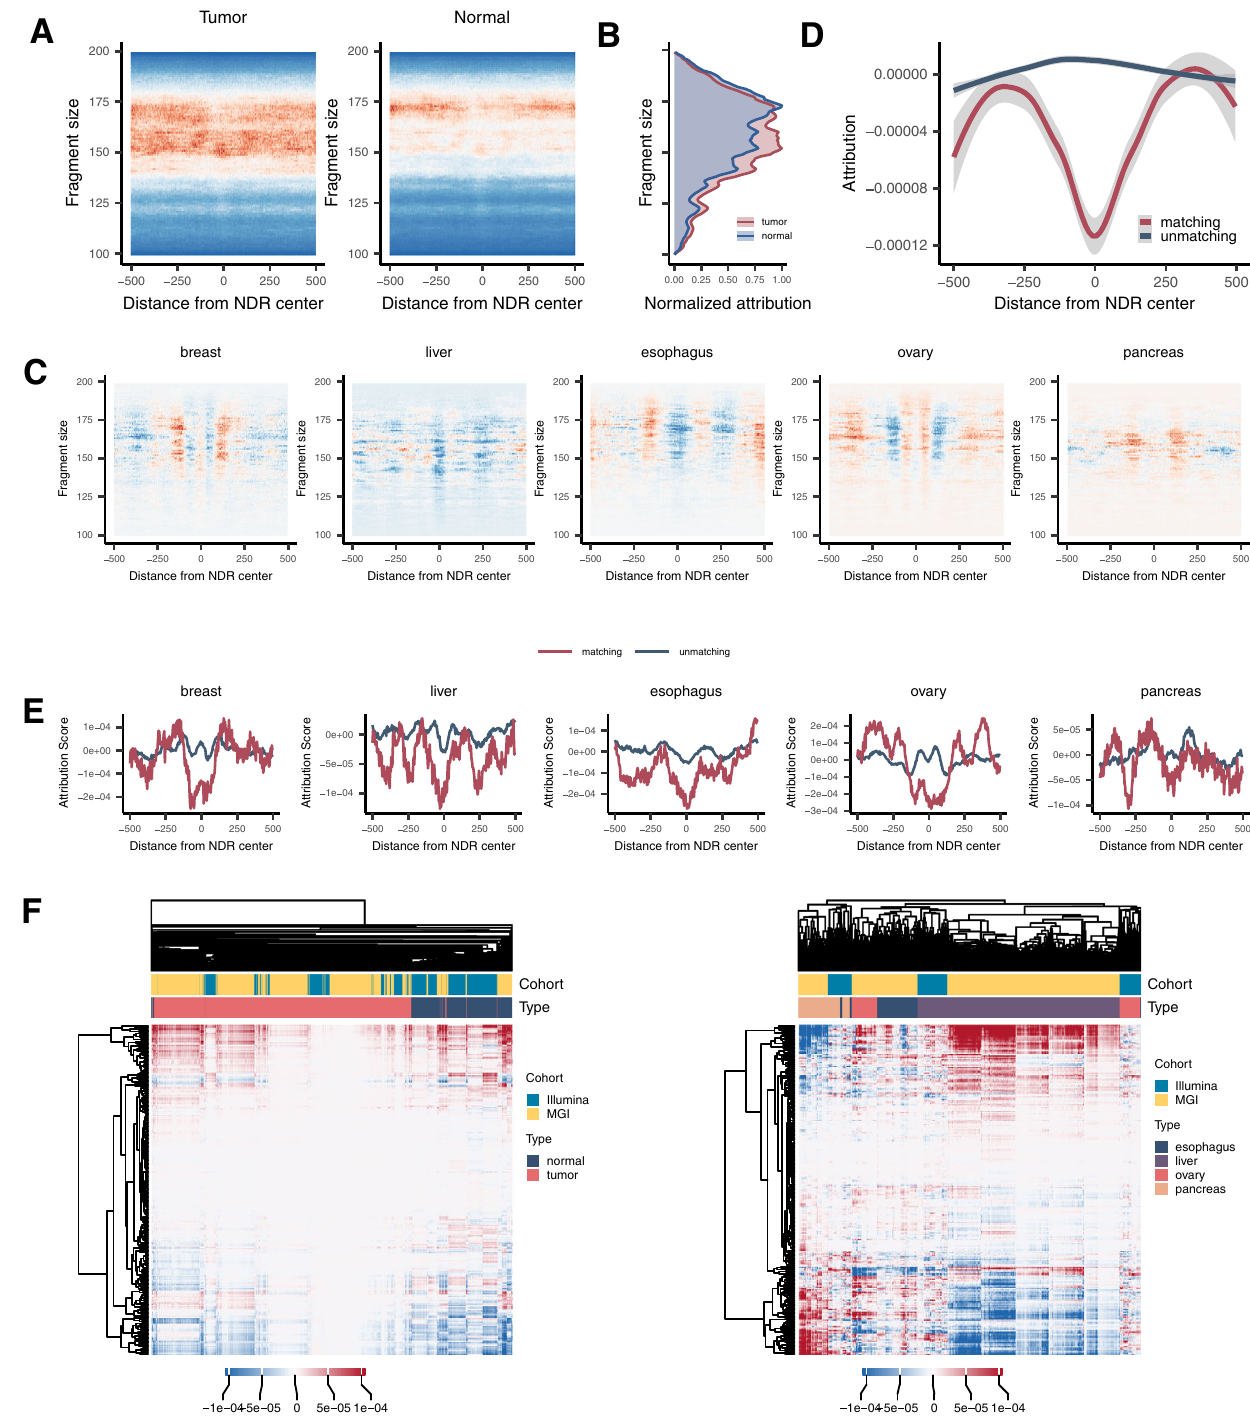
Fig. 6 | Interpretation of the epigenome model. A Attribution values mapped to thetissue-speci fi cV-plotsoftheepigenomemodelforcancerdetectionontheMGI trainingcohort.Theaverageattributionvaluesacrossthetissue-speci fi cV-plotsare compared for cancer samples (left) and normal samples (right). B Distribution of the normalized attribution values according to fragment size. C Attribution values mapped to the tissue-speci fi c V-plots of the epigenome model for tissue-of-origin localization on the MGI training cohort. The average attribution values across the tissue-speci fi c V-plots are shown for each cancer type. D Attribution values of the epigenome model for cancer localization on the MGI training cohort, as averaged across the NDRs of the matching (red)versus unmatching (blue)cancertypes,and